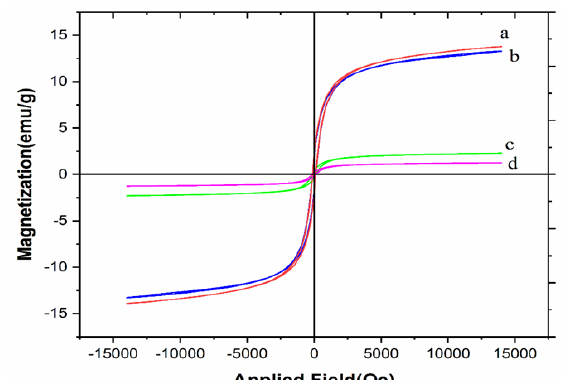
Fig. 4. The VSM curve of: (a) CdFe